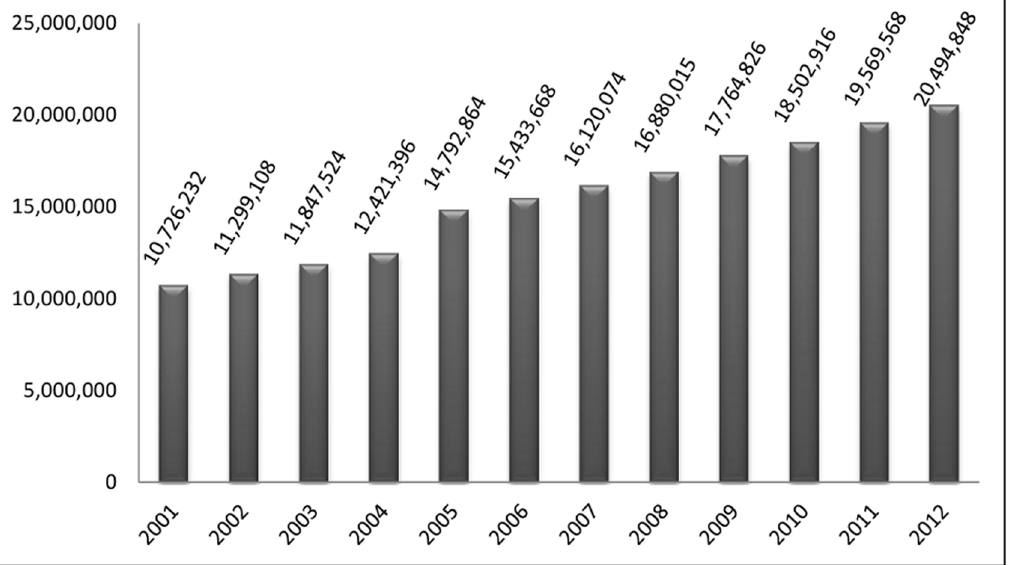
Figure 4. Growth of articles in MEDLINE. A bar chart displaying the number of baseline records in NLM MEDLINE’s 2001 baseline release to 2012 baseline release.